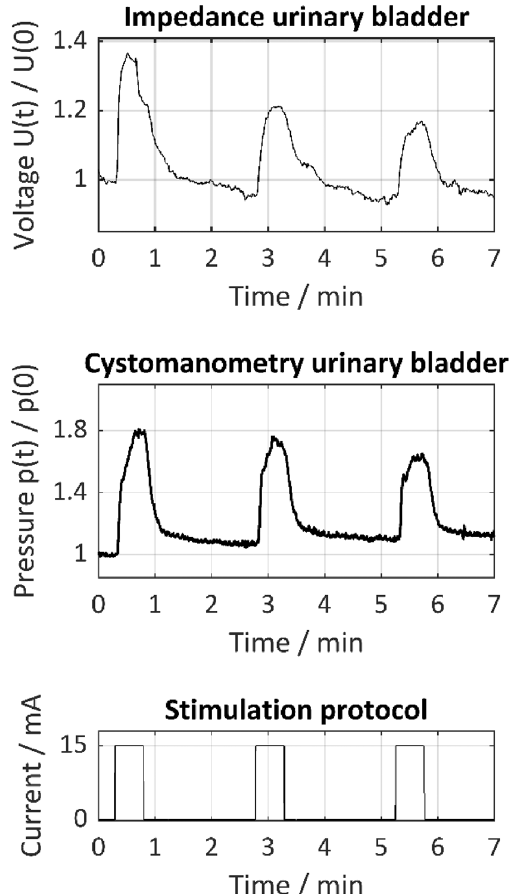
Figure 4. Normalized tissue impedance of the urinary bladder U(t)/U(0) and cystomanometry p(t)/p(0) as a function of time during direct nerve stimulation with 15 mA, 1000 µs pulse width and 30 Hz on the vesicouterine ligament according to the depicted stimulation protocol. Impedance measurement was carried out with four needle electrodes (setup 2). Tissue impedance of the bladder and bladder pressure are consistent and rise during direct nerve stimulation and decrease during